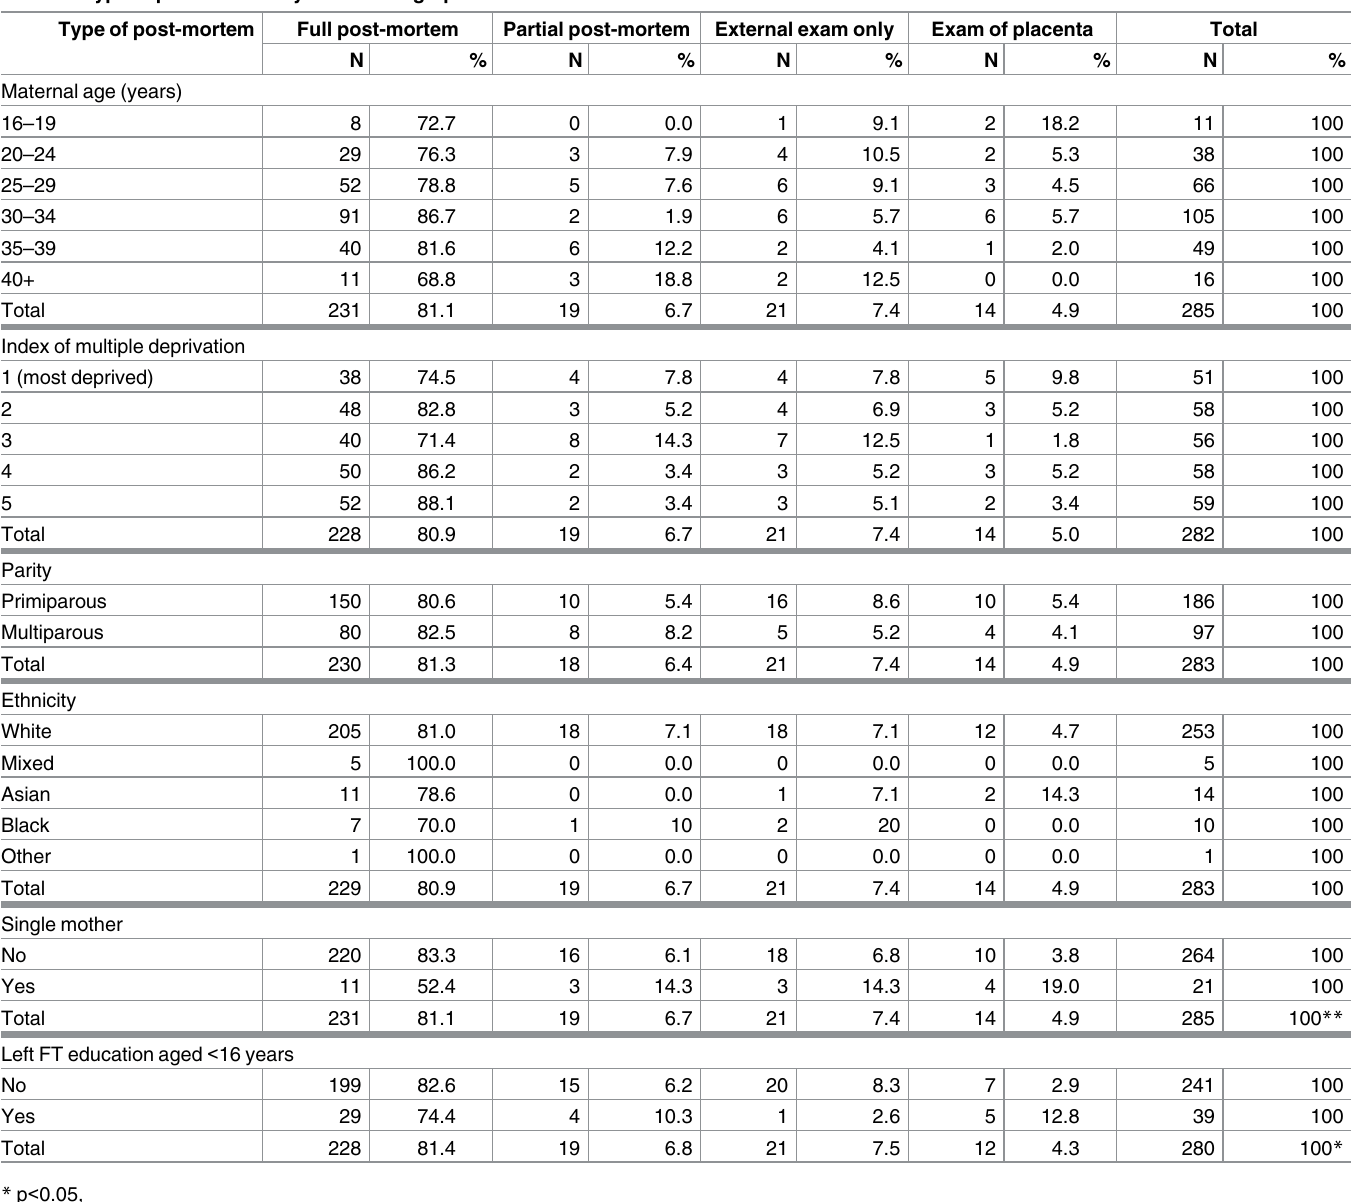
Table 3. Type of post-mortem by sociodemographic